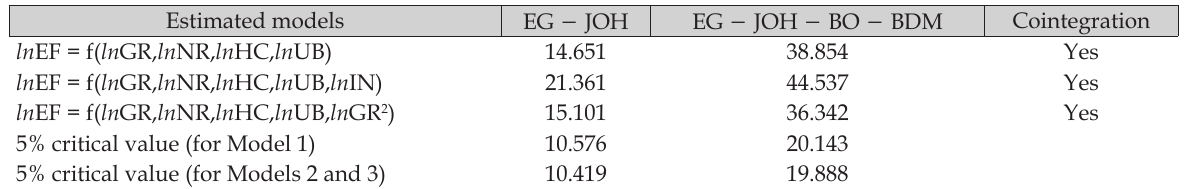
Table 7. BH test